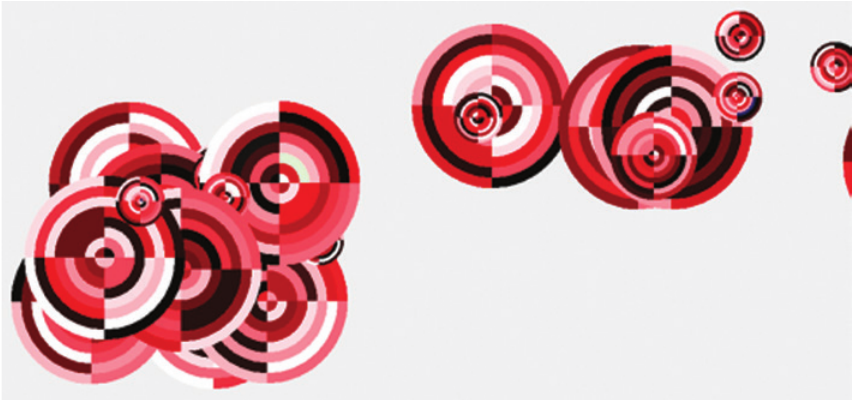
Figure 13: Best Individual Overall from Experiment 18.